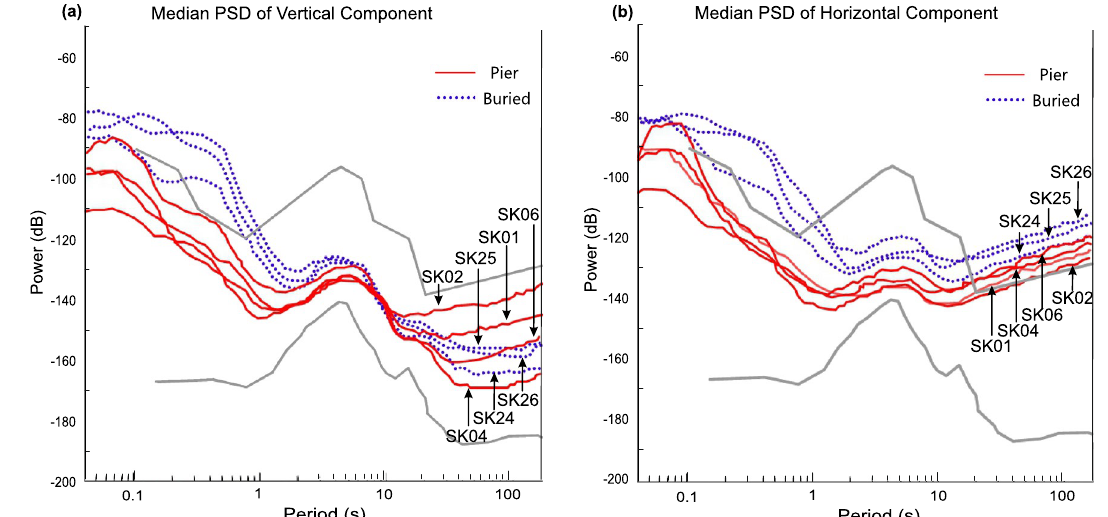
Figure 4. Median Power Spectral Density (PSD) plots to compare noise levels recorded at the sensors based on their installation techniques. The median PSDs of sensors recording long-period noise higher than the upper global noise limit (NHNM) in the horizontal components are plotted. Red solid lines represent median PSDs obtained using data recorded at stations where the sensor was installed above the ground on the pier. Blue dotted lines represent median PSDs obtained using data recorded at stations where the sensor was buried underground. ( a ) Median PSDs observed at the vertical component of 7 stations. ( b ) Mean of the Median PSDs observed for each horizontal component of 7 stations.